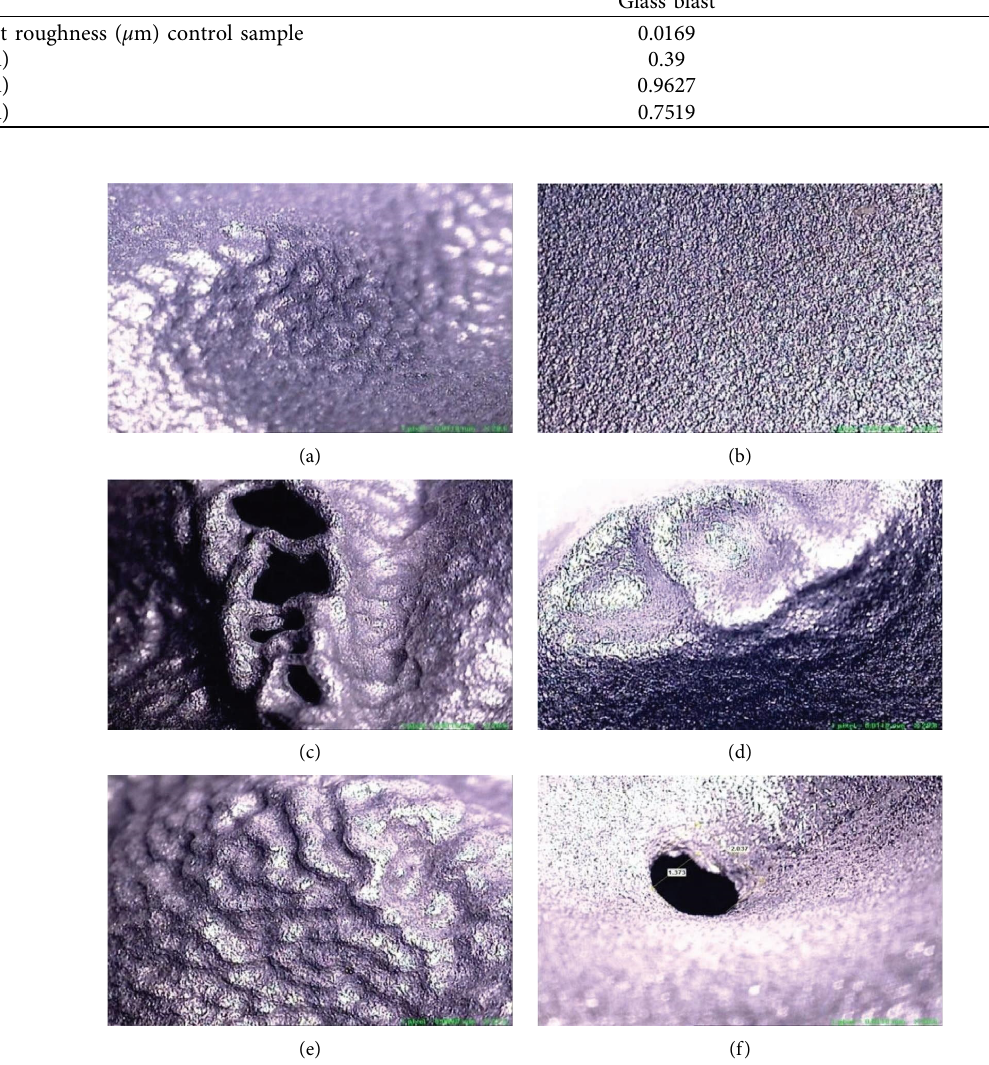
Figure 5: Maximum blast damage predicted for glass and SS sand blasting on aluminium surface. (a) Glass blast 5bar pressure, (b) SS sand blast 5 bar pressure, (c) glass blast 6bar pressure, (d) SS sand blast 6bar pressure, (e) glass blast 7bar pressure, and (f) SS sand blast